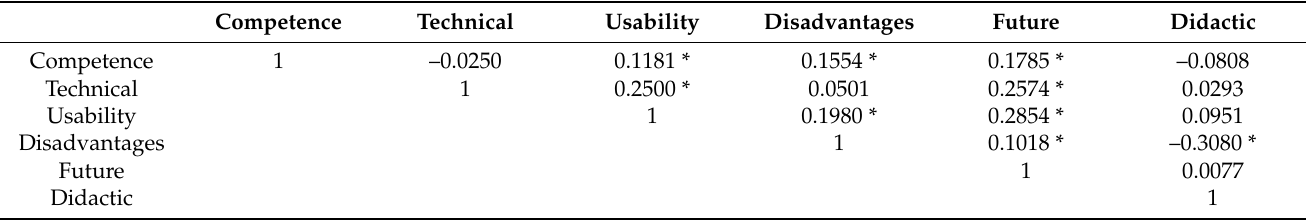
Table 5. Pearson correlations between the responses of the different families of questions, among the Engineering professors, with indication of those correlations that are statistically significant.